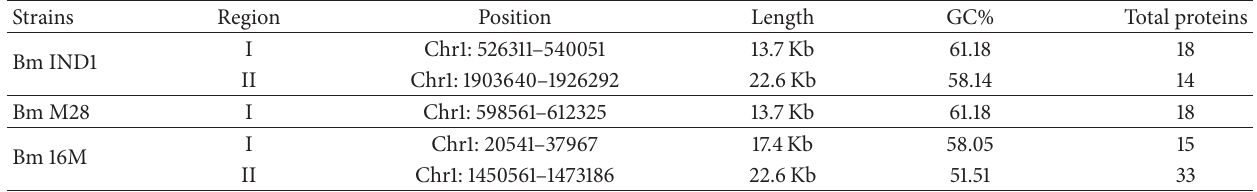
Figure 4: Phylogenetic tree showing relationship between B. melitensis IND1 and other B. melitensis strains. Maximum likelihood tree of 49 whole genome sequenced B. melitensis strains, inferred from concatenated, partitioned alignment of 2319 core genes using RAxML. Support values of branches are calculated from 100 bootstrap replicates and the branch length is proportional to the number of substitutions per site. B. abortus 2308 has been used as outgroup species. Table 3: Prophage regions detected in B. melitensis